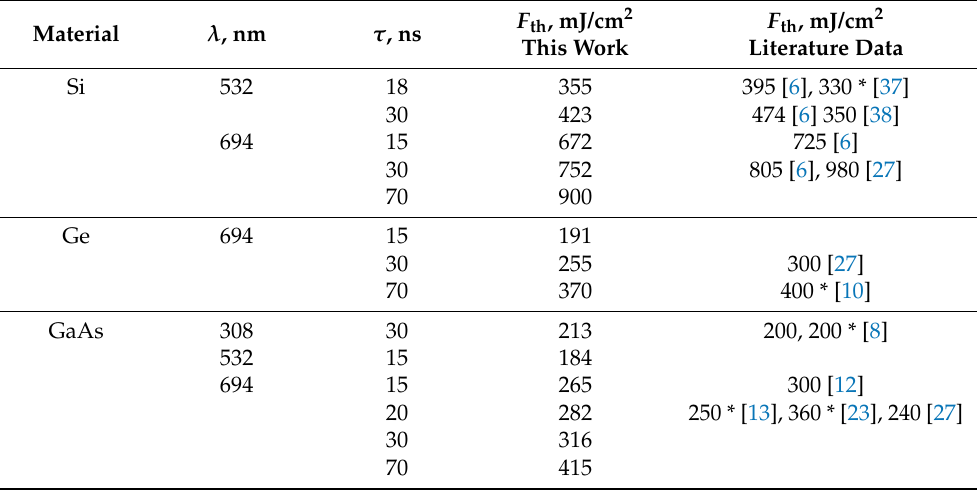
Table 1. The simulation results for the damage threshold fluence, F th , of the studied semiconductors in comparison with theoretical and experimental data reported in the literature. The experimental data are marked by asterisks